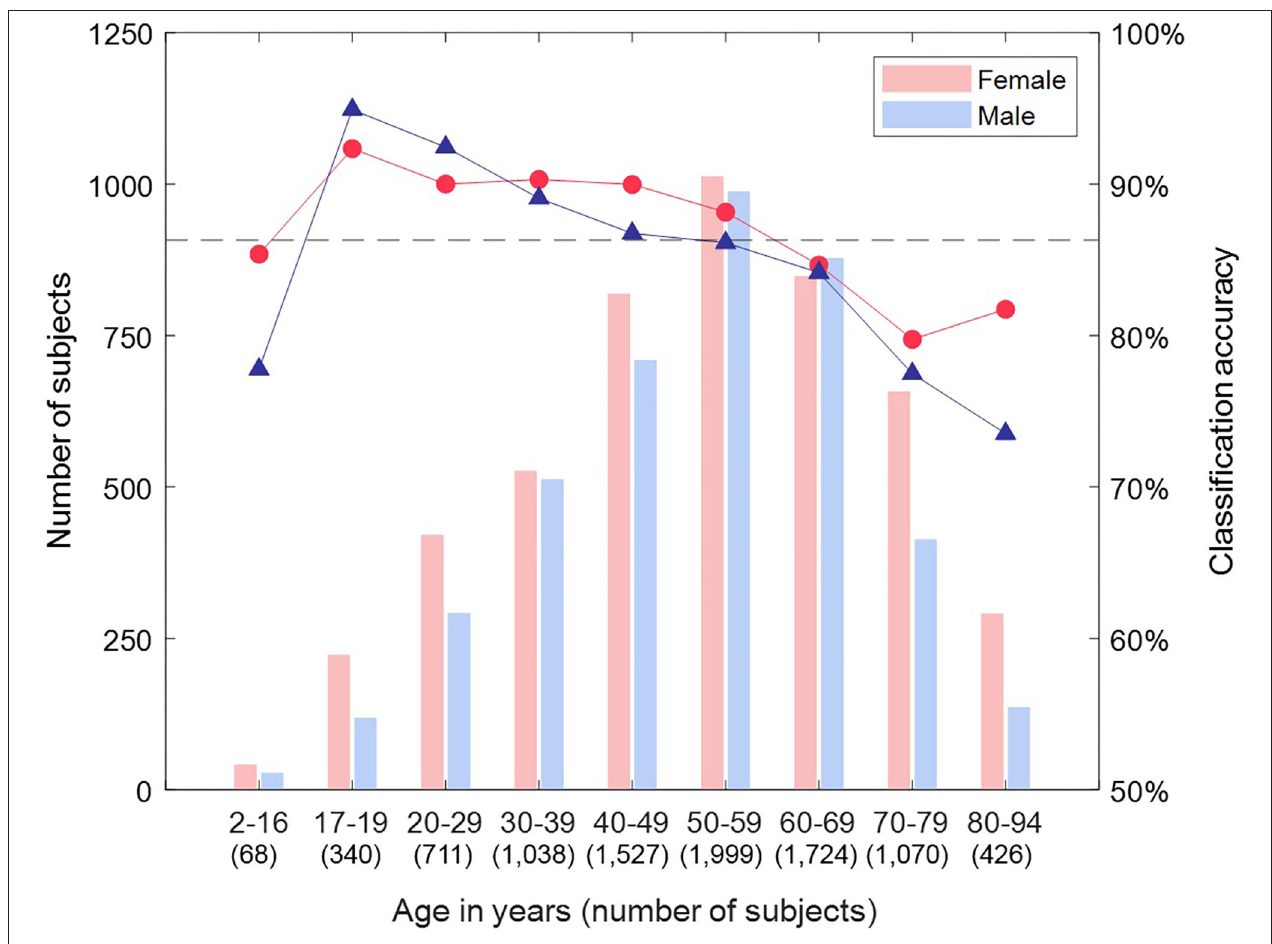
FIGURE 7 | Classification accuracy by sex and age group for Dataset 2. Breaking down the classification result by age showed that accuracy is highest for young adults through to 60 years old. In particular, young adult males were classified most accurately. The accuracy for children and older adults is lower, particularly falling for males over 70